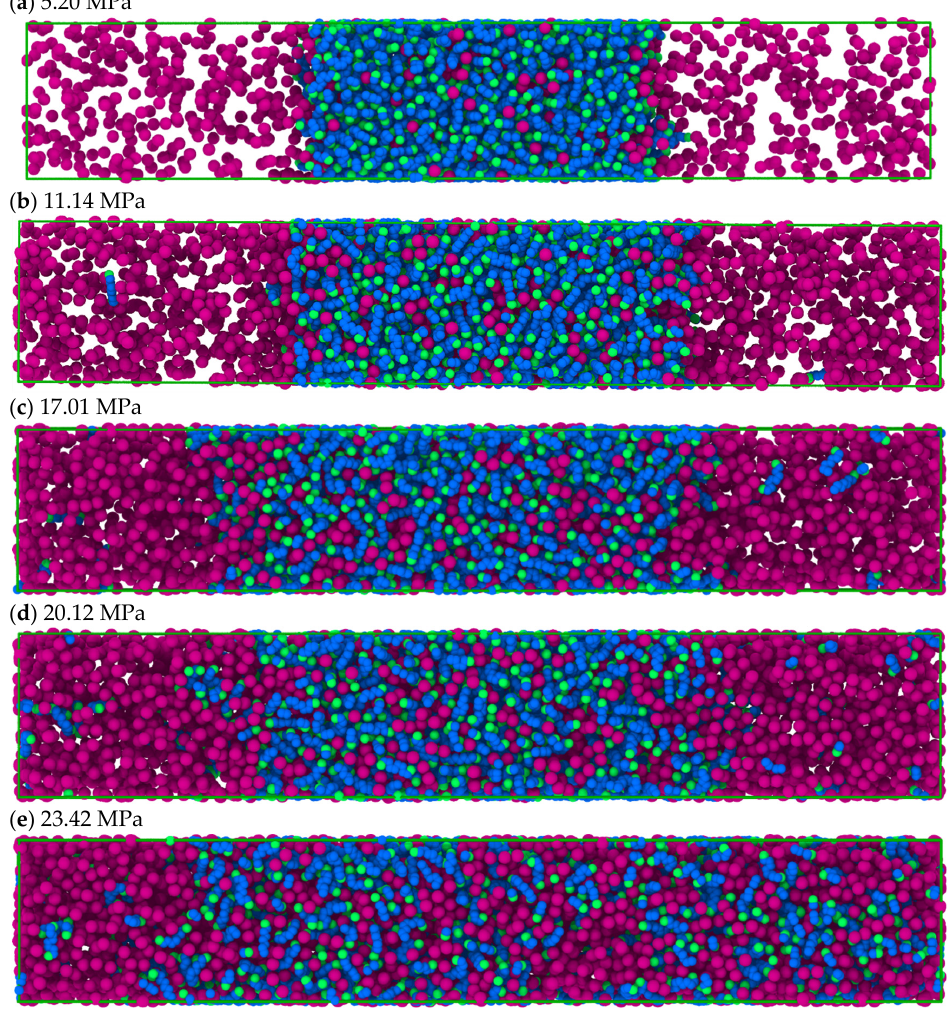
Figure 2. Snapshot of the equilibrium state of CH 4 + n-decane at 313.3 K.